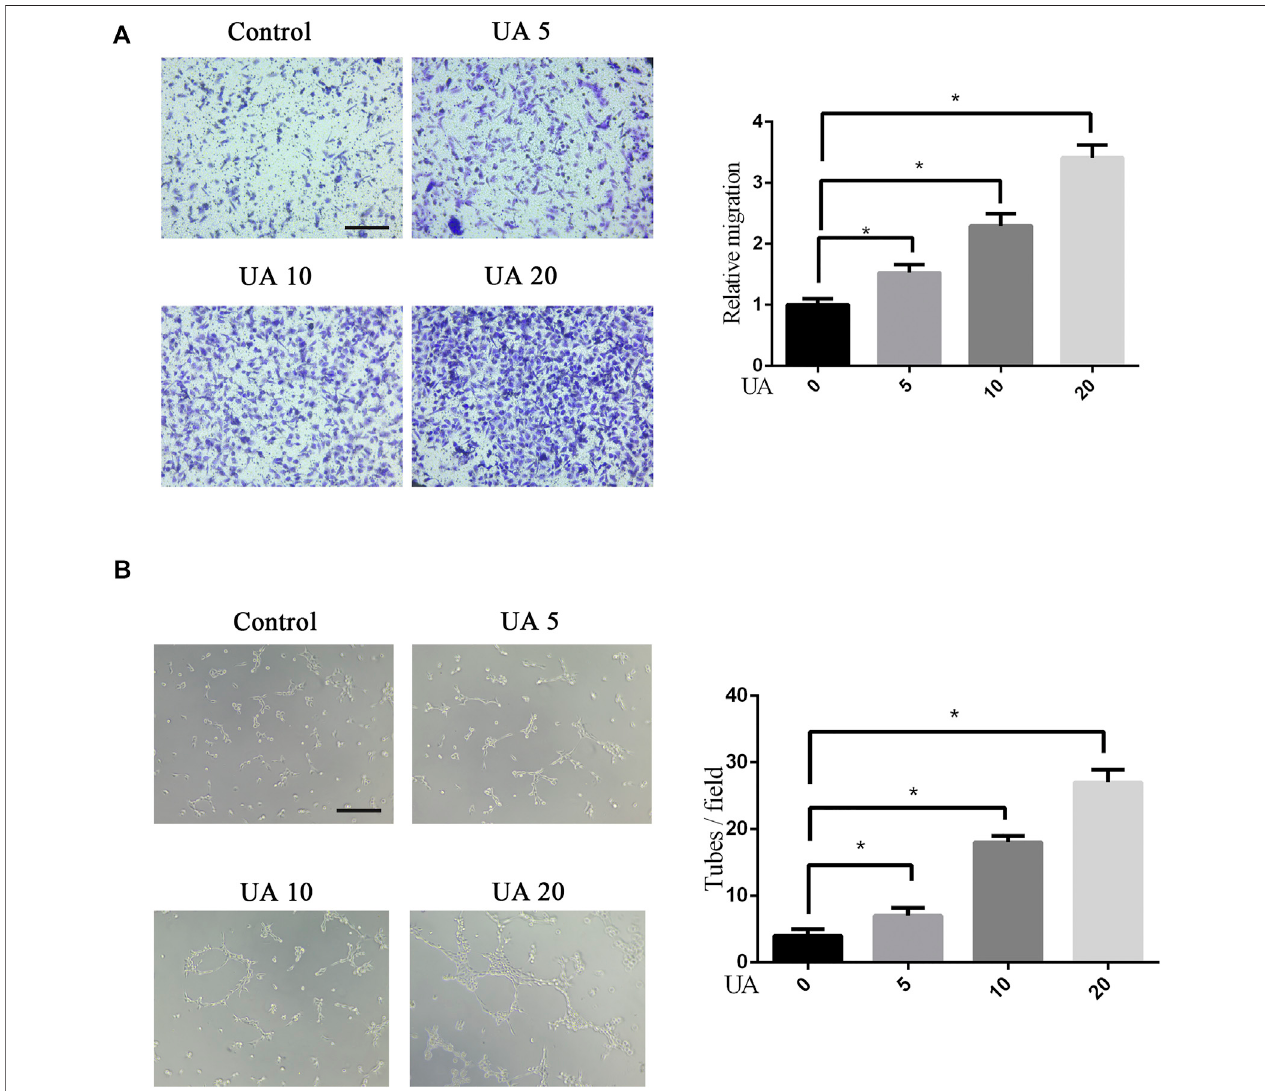
FIGURE 2 | Effects of UA on cellular migration and tube formation of HUVECs. (A) Transwell chemotaxis test results of different treatments of HUVECs. The migration of HUVECs was enhanced after UA treatment (5, 10, and 20 μ M UA). Statistics of the migration experiment. (B) After UA treatment, the tube-forming capacity of HUVECs is improved. Statistics of the tube-forming experiment. Scale bar = 100 μ m. The data represent mean ± SD ( n = 3) (* p < 0.05).